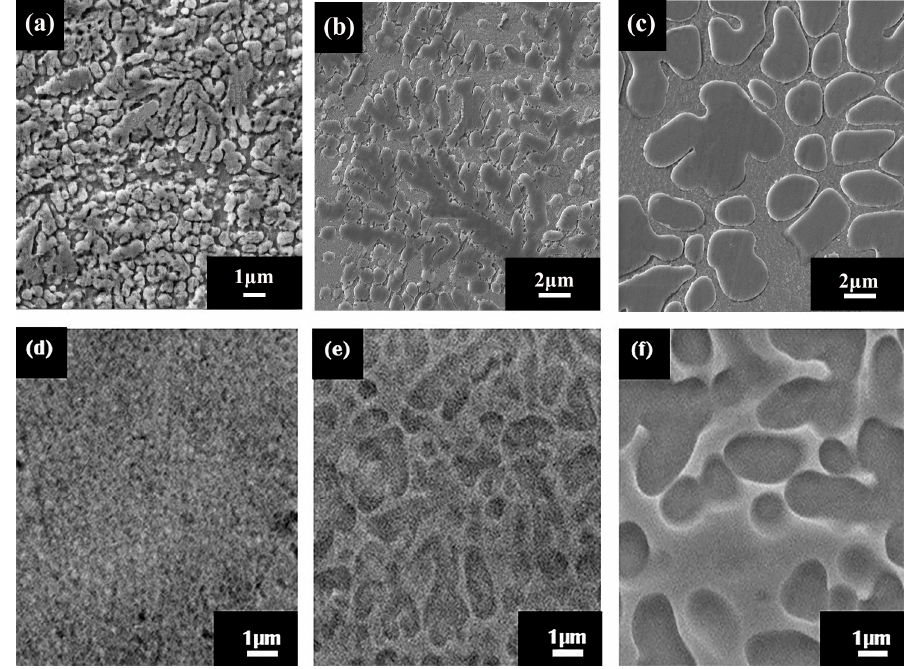
Figure 4. The SEM micrographs of the surfaces of in-situ MGMCs after chemical tests in the 10% H 2 SO 4 solution for 1 week shown. The images of as-cast ingots, with ( a ) Φ 2 mm, ( b ) Φ 3 mm and ( c ) Φ 6 mm, respectively. The images after the chemical tests, with ( d ) Φ 2 mm, ( e ) Φ 3 mm and ( f ) Φ 6 mm, respectively.